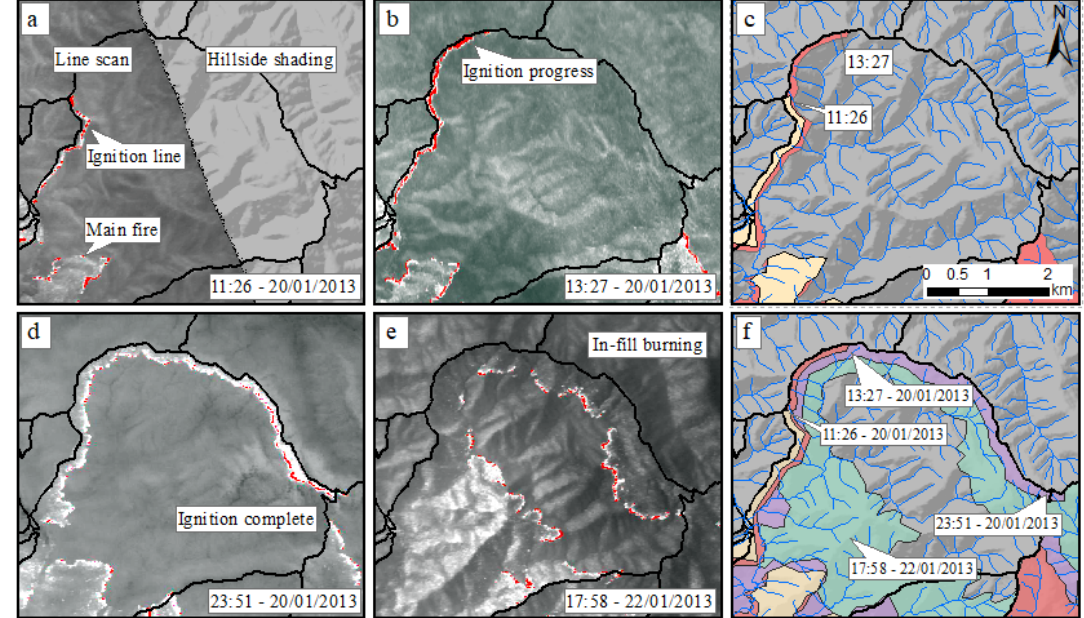
Figure 4. An archetypal backburn. ( a ) Hillside shading is used to illustrate how the grayscale of the line scan images varies with topographic features. The line scan images ( a , b , d , e ) capture the progress of the backburn. Active burning is highlighted by red, recently burnt (still hot) by white, unburnt and cooled areas by grayscale. A GIS road layer (black lines) overlays the line scans. ( c ) Hillside shading is overlayed with the road layer (black lines). Fire progression polygons (beige and red) map the extent of the fire that is visible in line scans images ( a , b ). At 11:26, ~2 km was alight (beige progression); by 13:27, backburning progressed a further ~1.7 km along the road in a northeasterly direction (red progression). ( d ) By 23:51, the ignition of this ~9-km backburn is complete. Initial fire spread was modest extending a few hundred meters from the road. ( e ) The intervening fuels were left to in-fill burn over several days. ( f ) All four progressions (color polygons) overlay the hillside shading as well as the roads (black lines) and watercourses (blue lines). The timing of the line scan images (progression) is indicated with the white text